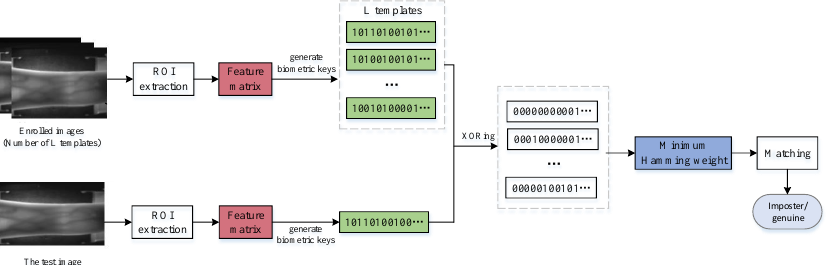
Figure 1. Overall framework of the proposed